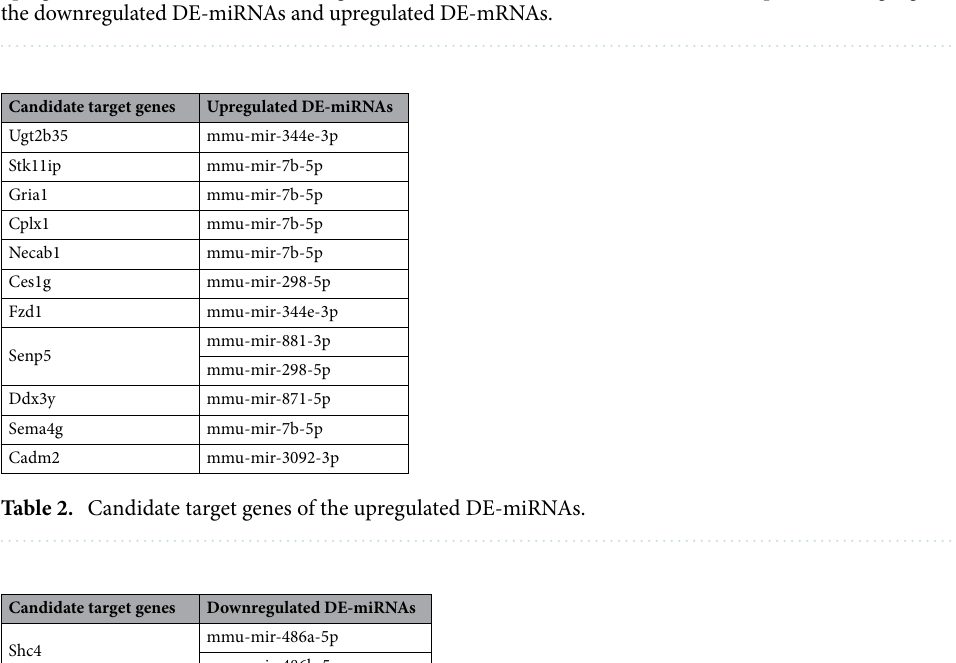
Figure 5. Identification of candidate target genes. ( A ) The intersection of the predicted target genes of the upregulated DE-miRNAs and downregulated DE-mRNAs. ( B ) The intersection of the predicted target genes of the downregulated DE-miRNAs and upregulated DE-mRNAs.